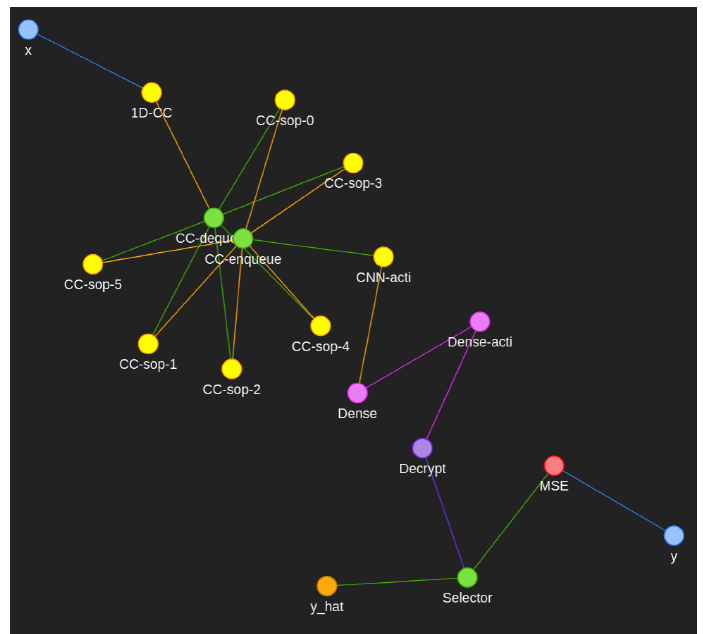
Figure 4. FHE compatible neural network graph implemented by Python-ReSeal [22], visualised using PyVis, deployed towards predicting time series milk yield data via 1D Convolutional Neural Network (CNN)/biased cross-correlation (CC) with activation. Further in this diagram, blue repre- sents input nodes, yellow represents CC/CNN nodes/components, pink represents the dense layer to condense the feature vector from the CNN layer, green is all glue operations such as enqueue and dequeue to merge and split inputs along varying edges respectively, orange is predictions, and red is loss functions. Purple is a special/unique set of operations related to the encryption itself such as decryption before moving on to the final